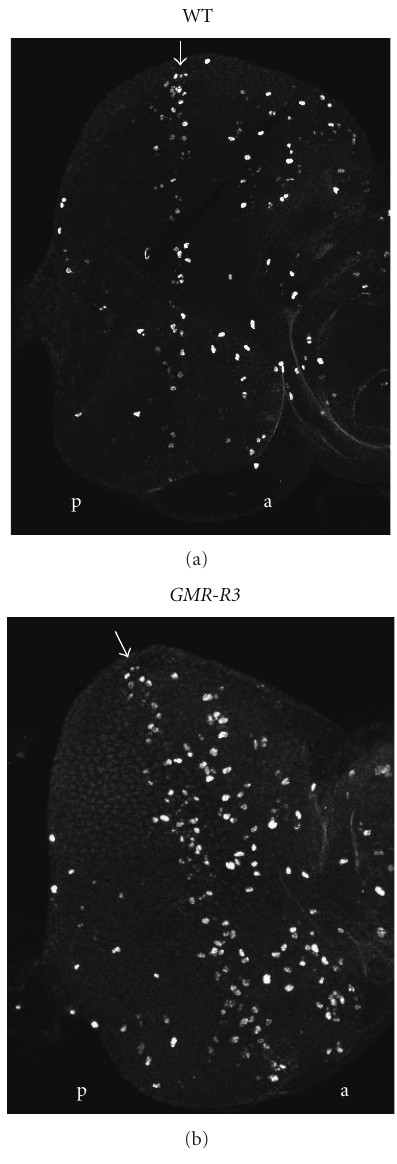
Figure 4: Increased cell division in GMR-R eyes. Third instar eye imaginal discs from wild-type (a) and GMR-R3 (b) larvae were stained with anti-phospho-histone-H3 (Ser 10) antibody. Confocal microscopy was used to image the discs. Arrows refer to the mor- phogenetic furrows. Posterior is to the left of each morphogenetic